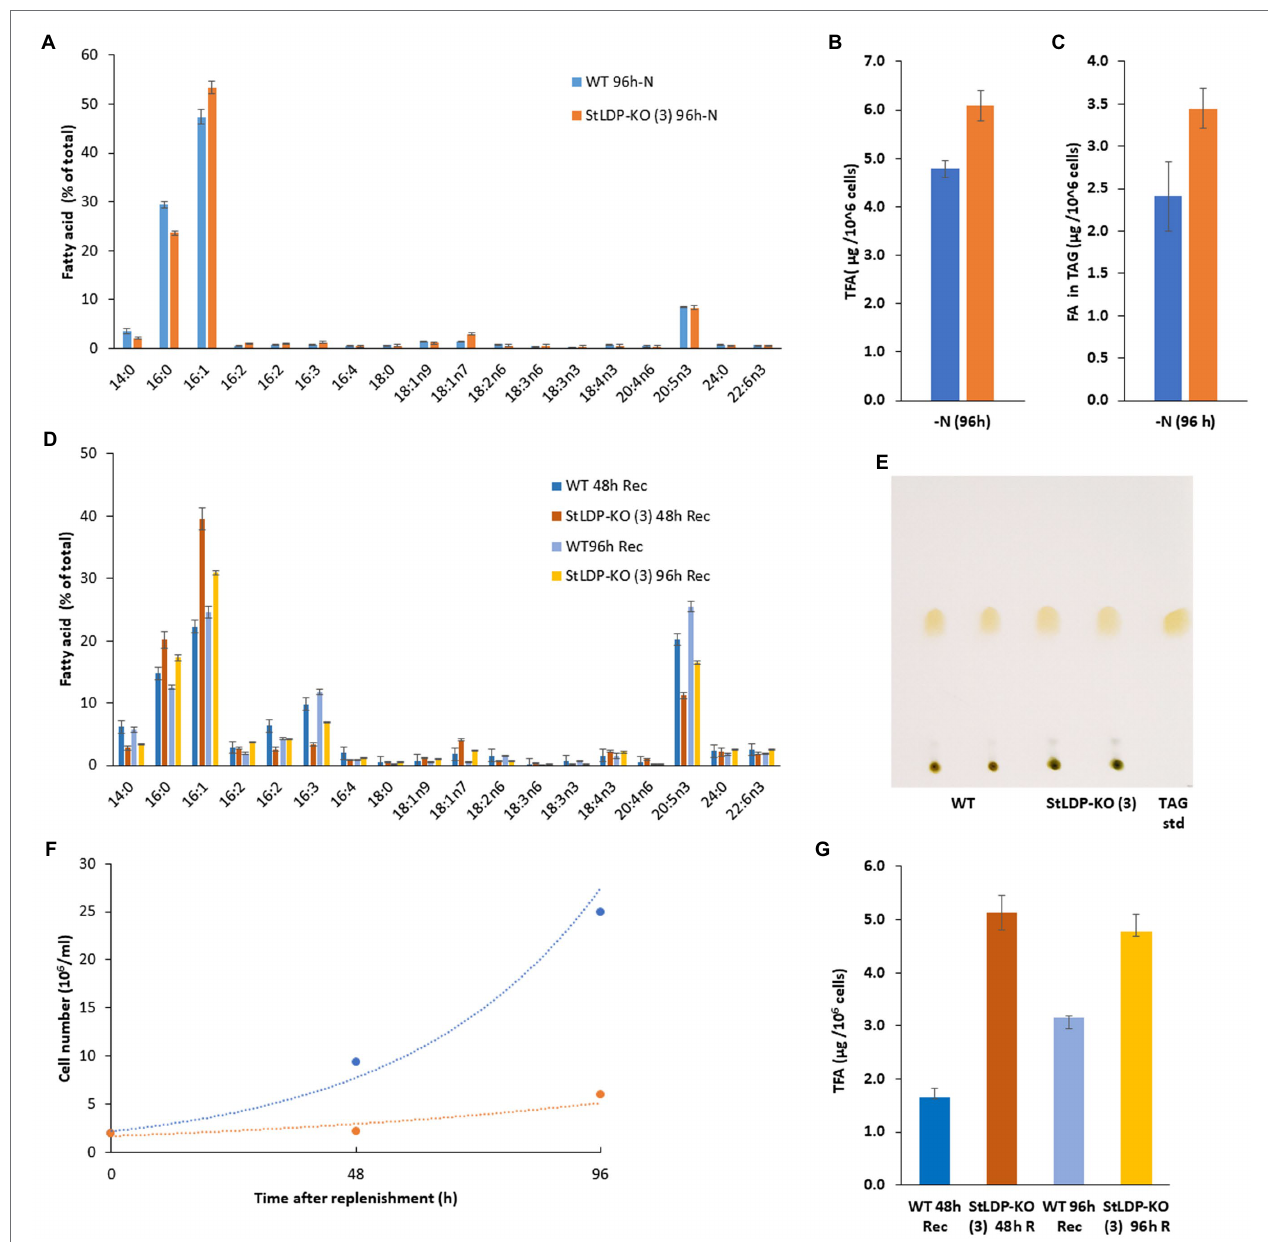
FIGURE 6 | Comparative analysis of wild-type Pt1 and StLDP -KO (3) under N deprivation and following nutrient replenishment. (A) Relative abundance of fatty acids (% of total) after 96 h of cultivation in the N-deprived medium. (B) Total fatty acid content ( μ g/10 6 cells) after 96h of N deprivation. (C) Fatty acid content in TAG ( μ g/10 6 cells) after 96h of N deprivation. The initial cell density − 5 × 10 6 cells/ml. (D) Relative abundance of fatty acids (% of total) during recovery from N-deprivation. (E) Isolation of TAG from N -deprived cells by TLC: total lipids were loaded based on the equal cell number. (F) Cell concentration dynamics after nutrient replenishment. The initial cell density − 2 × 10 6 cells/ml. (G) Relative abundance of fatty acids (% of total) 48 and 96 h after nutrient